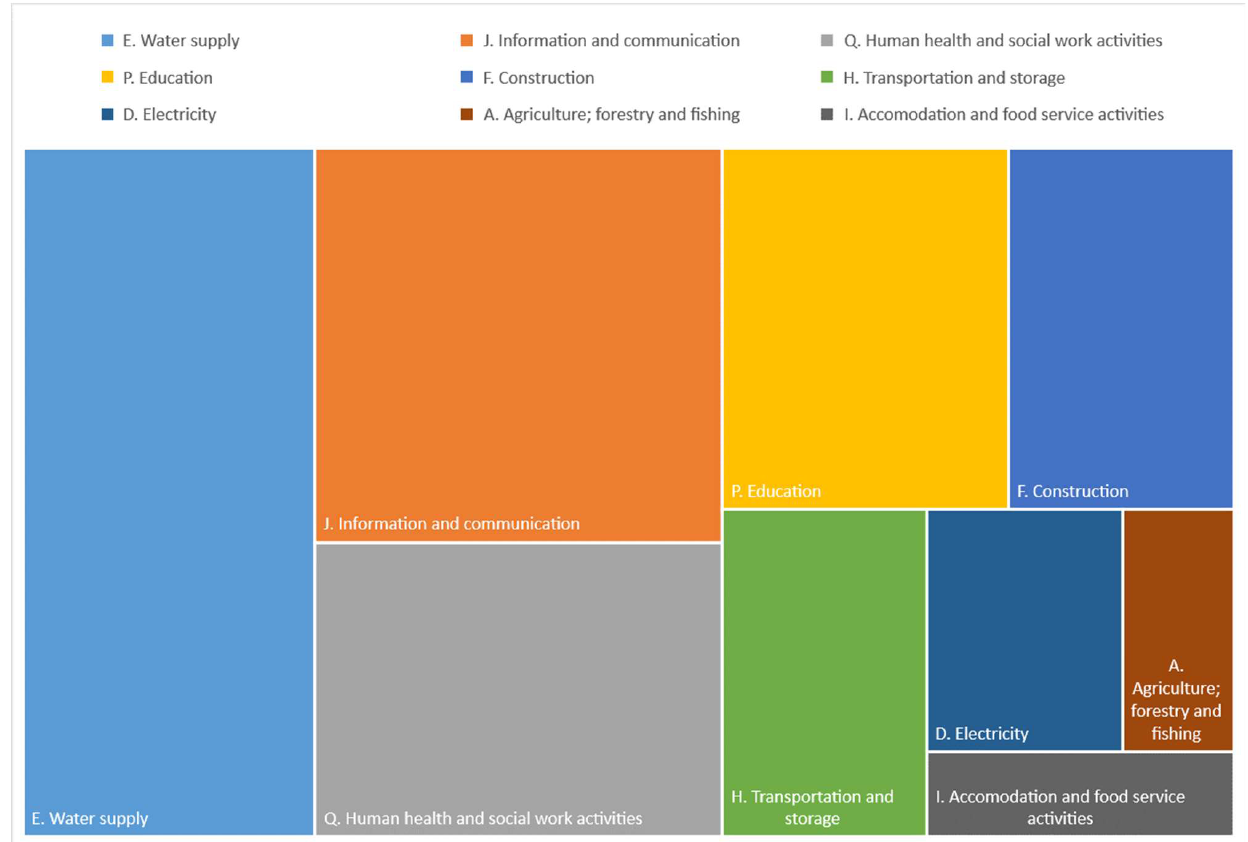
Figure 6. Treemap of the relative weight of the sectors of activity.